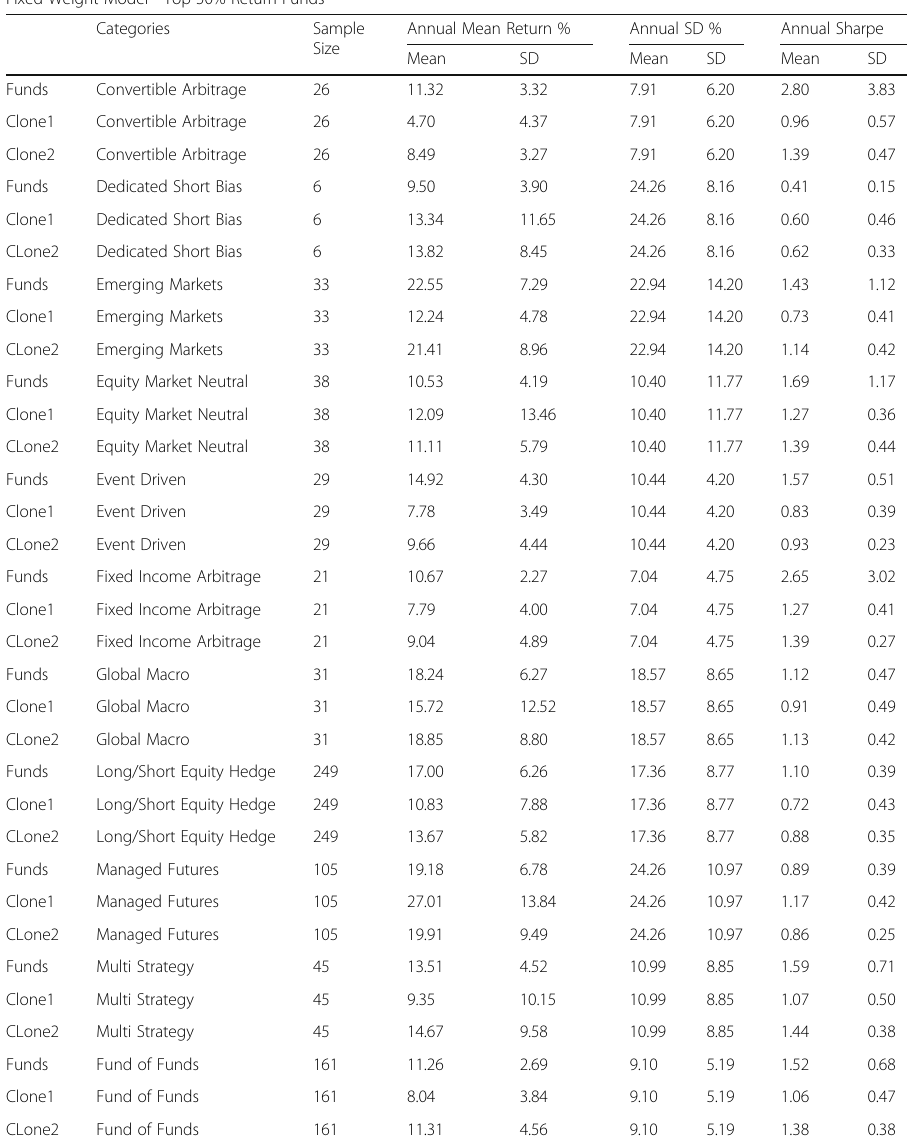
Table 5 Performance comparison for fixed weight model for top 50% return funds and their